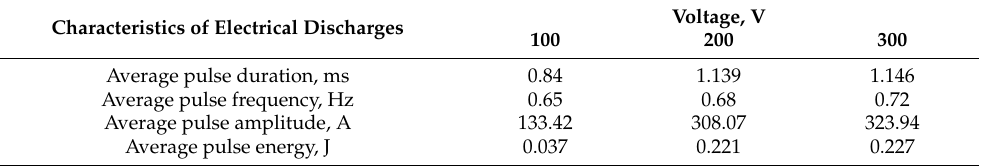
Table 1. Electric discharge parameters without controlling the pulse